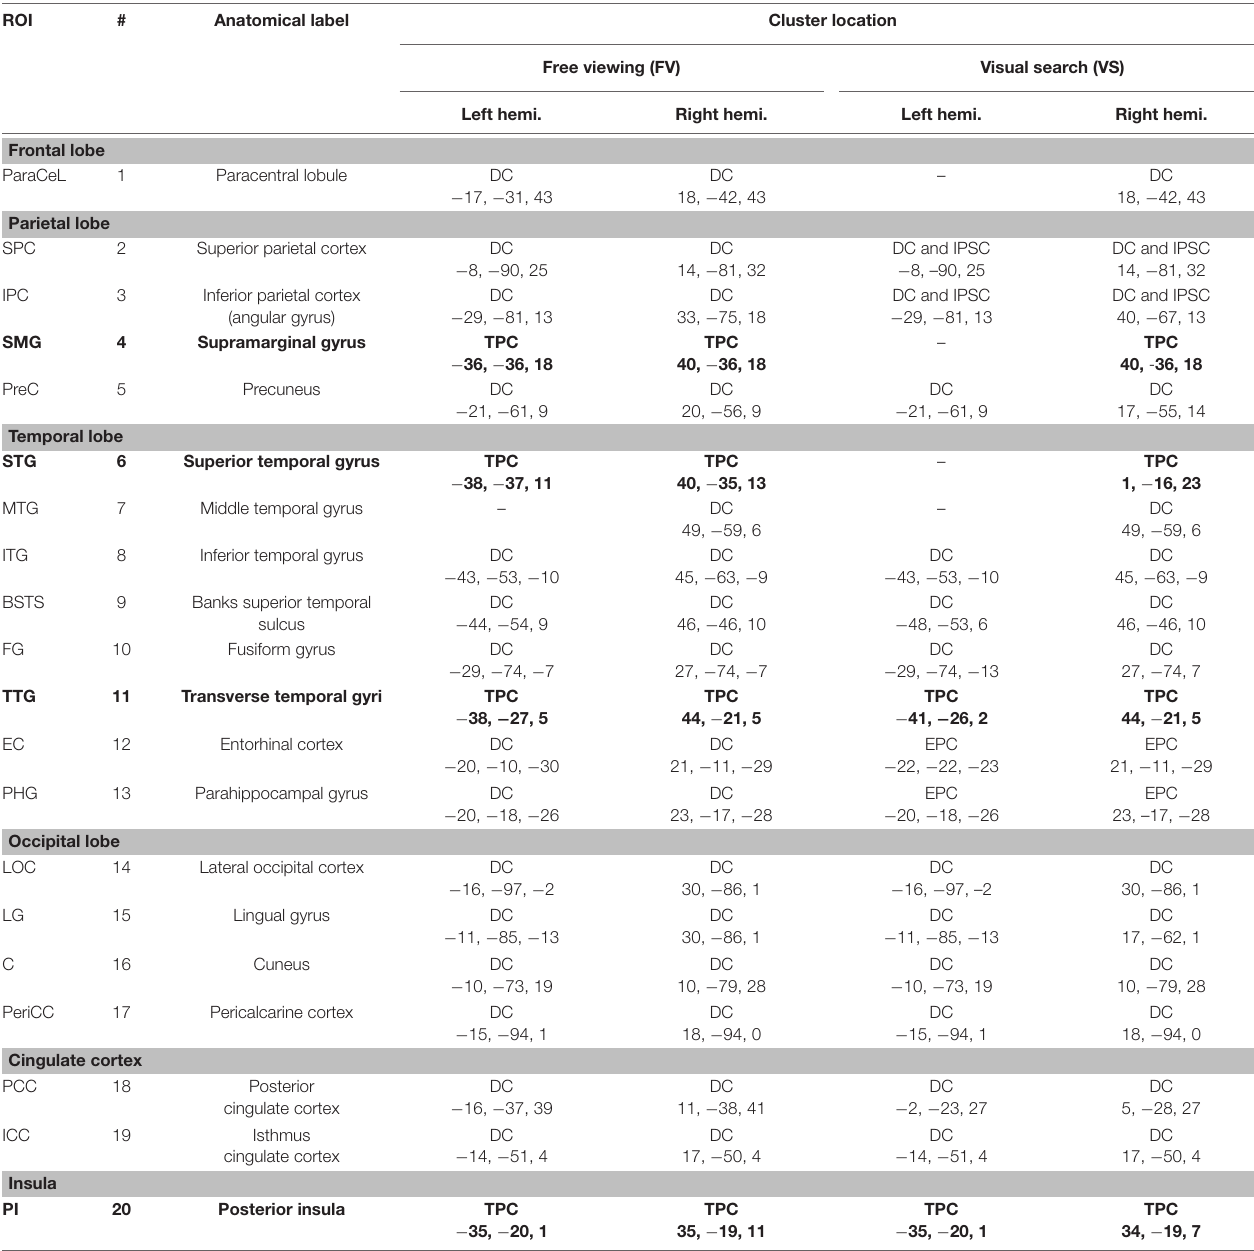
TABLE 1 | Regions of interest (ROIs) in the left and right hemispheres showing significant differences in activity between events during the image presentation and events during the presentation of the fixation cross. ROI # Anatomical label Cluster location Free viewing (FV) Visual search (VS) Left hemi. Right hemi. Left hemi. Right